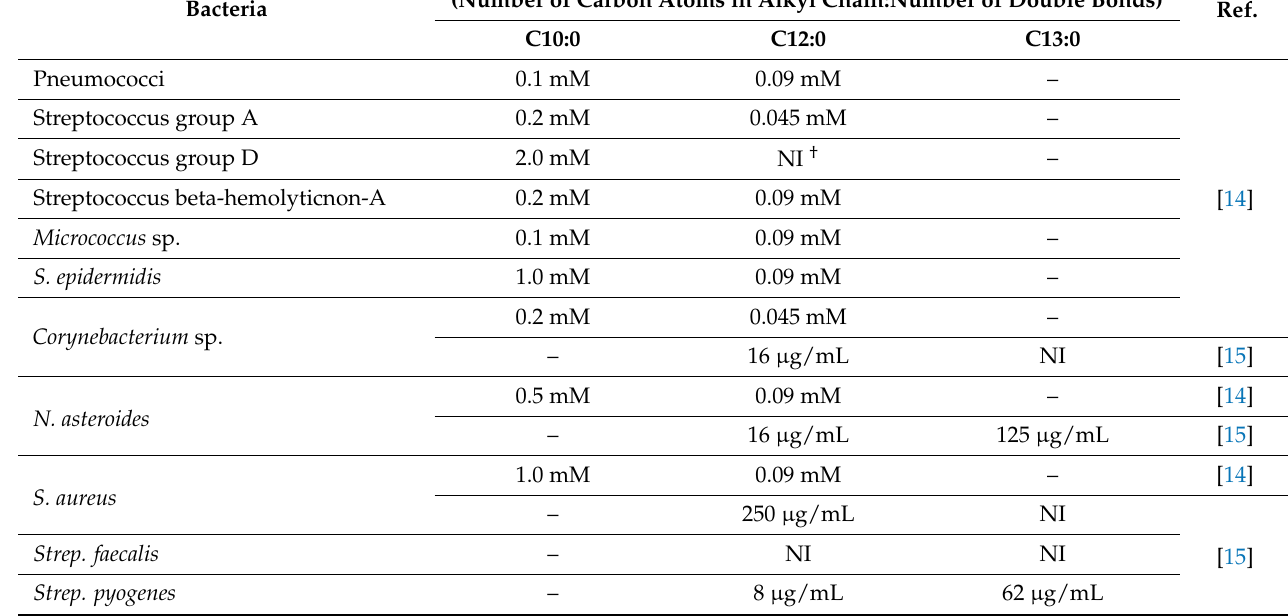
Table 4. Selected MIC values of monoglycerides against different Gram-positive